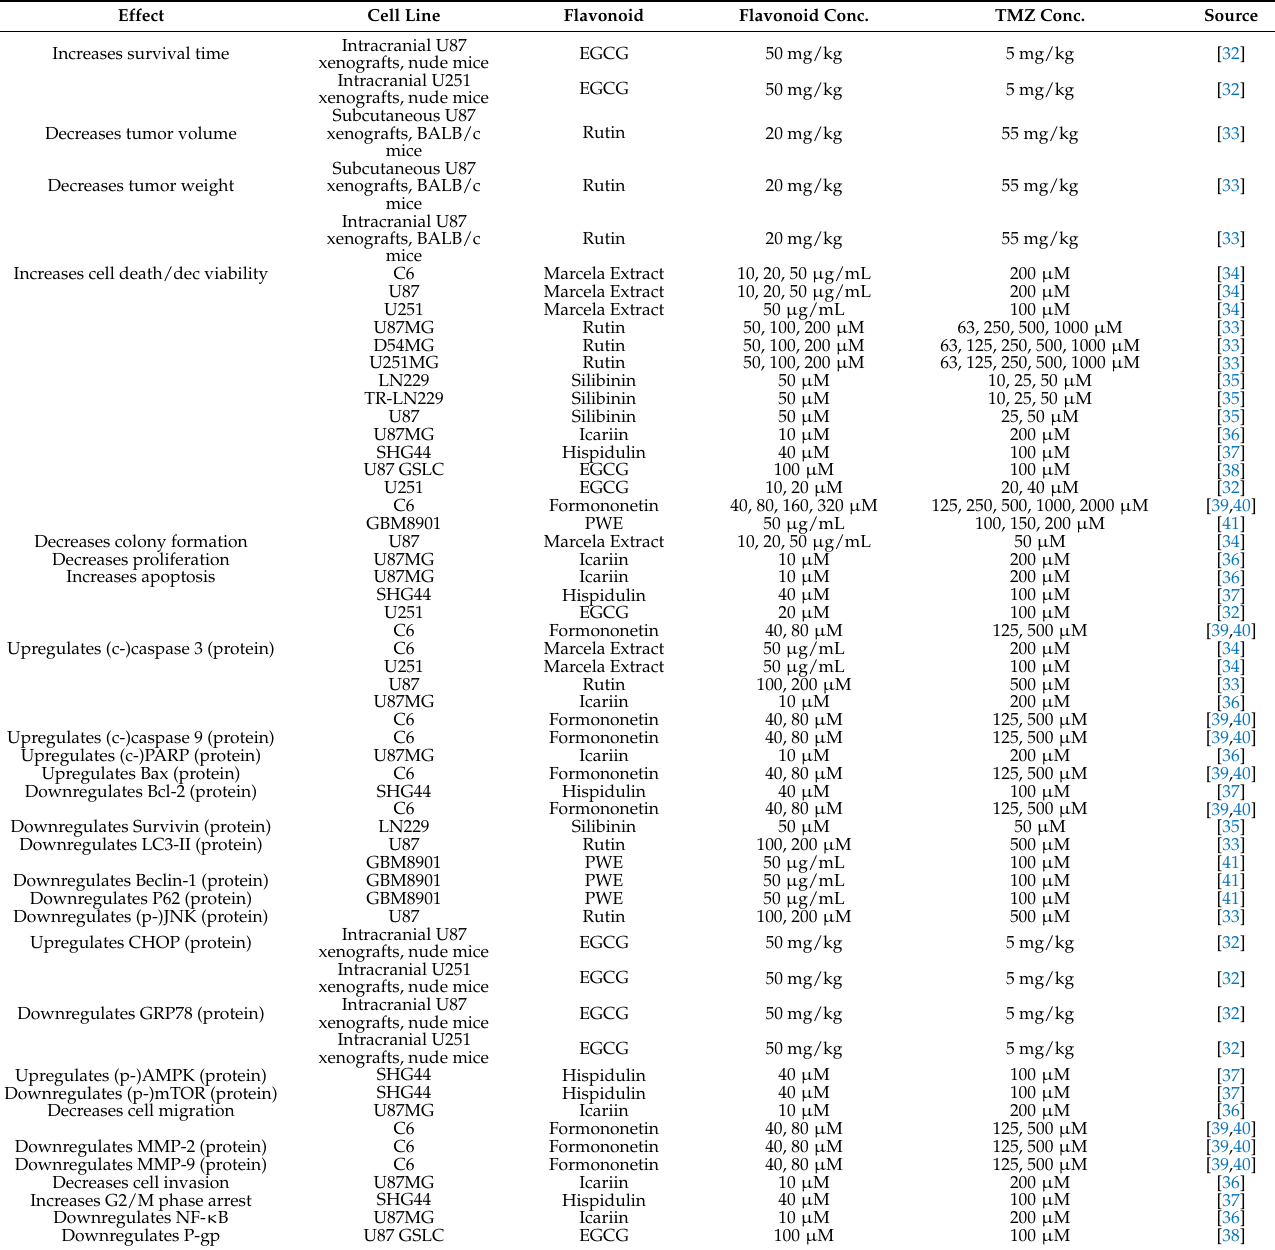
Table 3. Mechanistic anti-GBM effects of flavonoid-TMZ combinations, as demonstrated in vitro and in